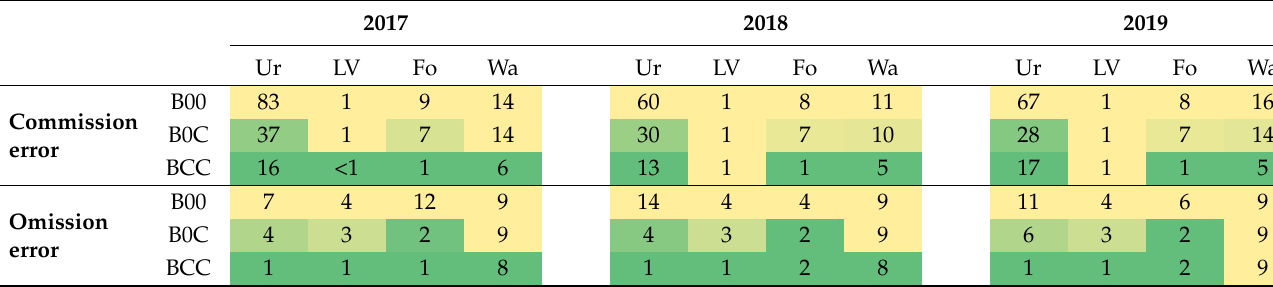
Table 4. Temperate site errors (%) disaggregated by land cover (Ur, Urban; LV, low vegetation; Fo, forest; Wa, water). B00— classification using backscatter annual statistics, B0C—adding long-term coherence, and BCC—further adding short-term coherence statistics. Complete matrices in Appendix A (Table A1). Cells are shaded with a green-yellow gradient, indicating lower and higher